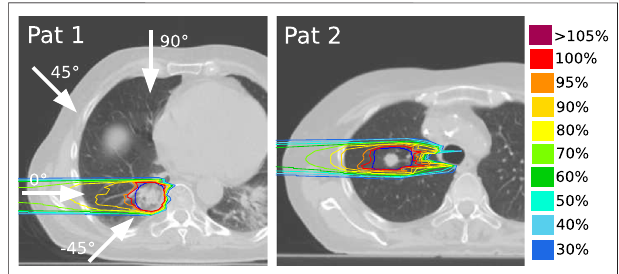
FIGURE 3 | Patient geometries and nonmodulated carbon ion dose distributionsforahorizontalbeam forP1 (left) and P2 (right) .Shown hereare the isocenter transversal slices. The arrows indicate the four different fi eld angles used in this work. The PTV contours are shown in dark